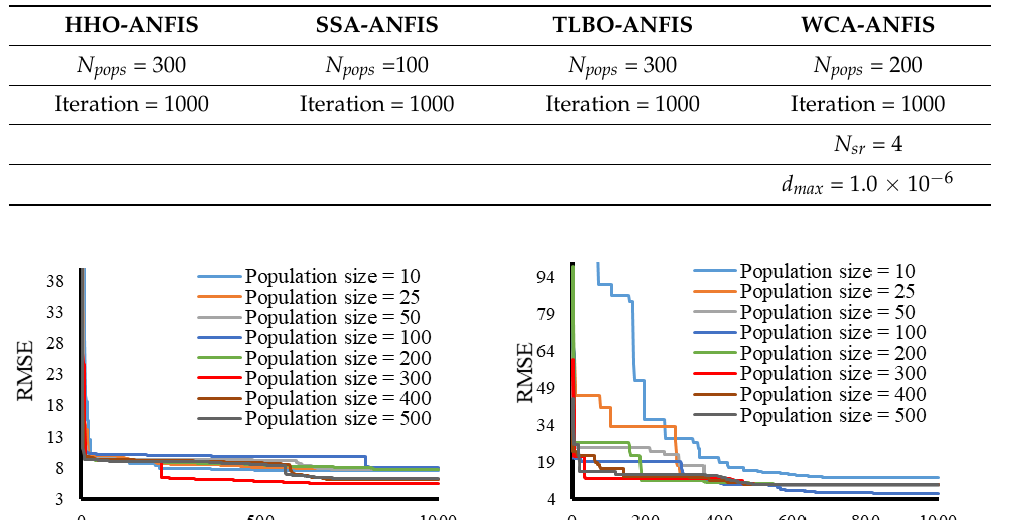
Table 2. Parameters of the implemented algorithms.